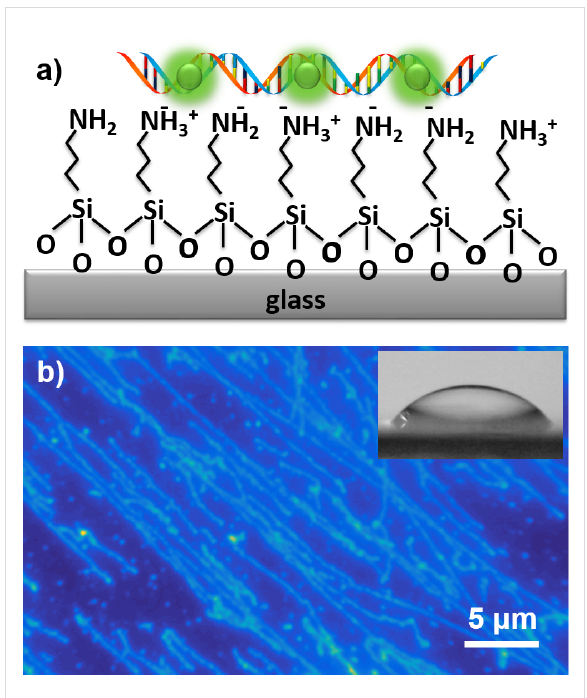
Figure 3: (a) Scheme of glass surface modification and DNA immobili- zation. (b) Fluorescent image of stretched DNA molecules on the sub- strate that have been labeled with YOYO-1. The inset shows a droplet of water on the substrate before DNA immobilization, giving a water contact angle of 48 ±